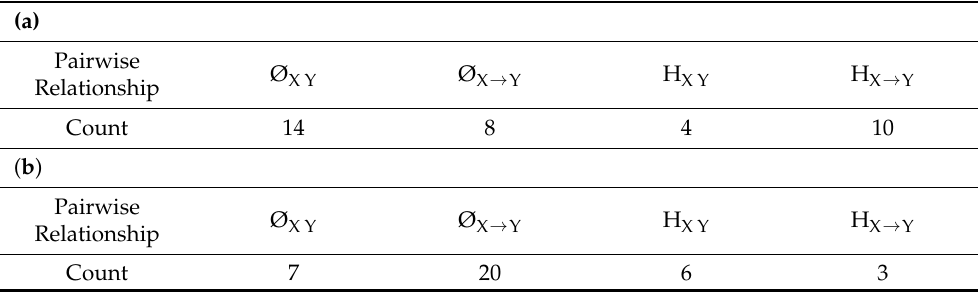
Table 1. Number of pairwise causal relationships in Close 9 variables (C9) and Sparse 9 variables (S9). H represents a variable that is shaded. (a) Close 9 variables (C9). (b) Sparse 9 variables